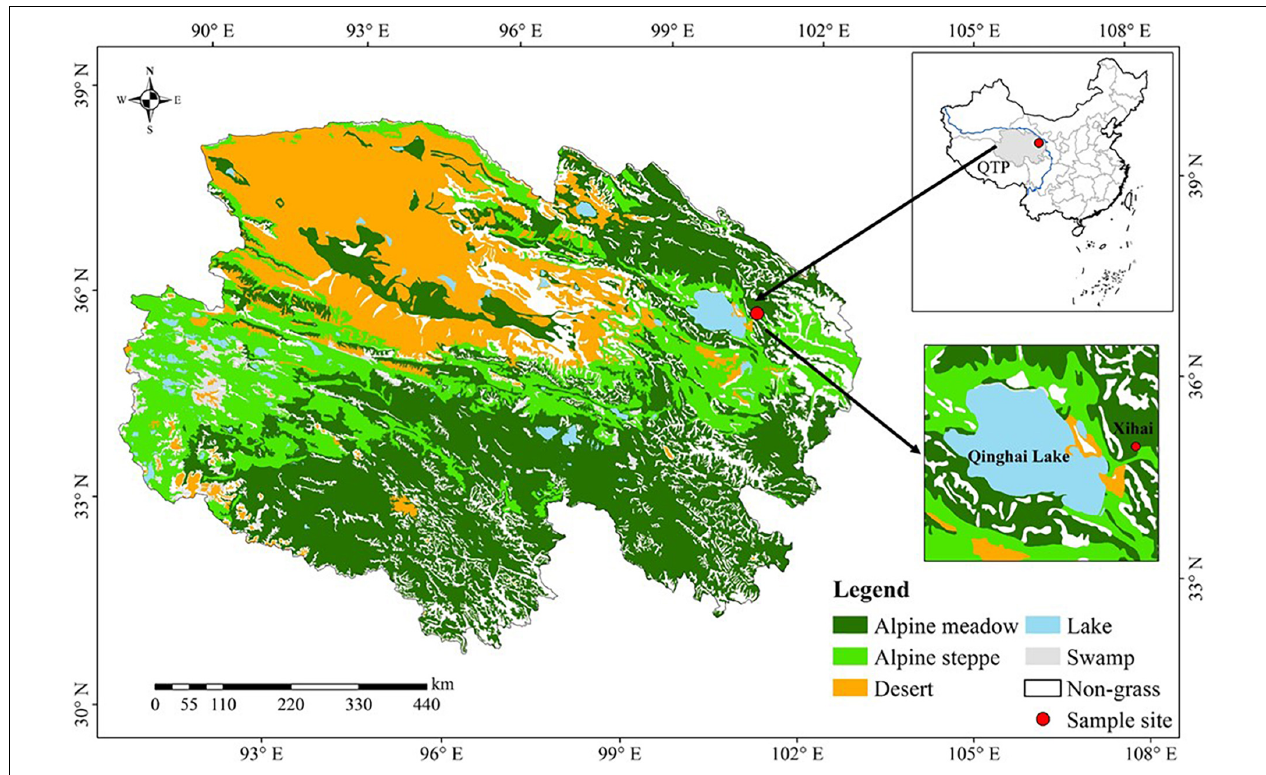
FIGURE 1 | The location of study